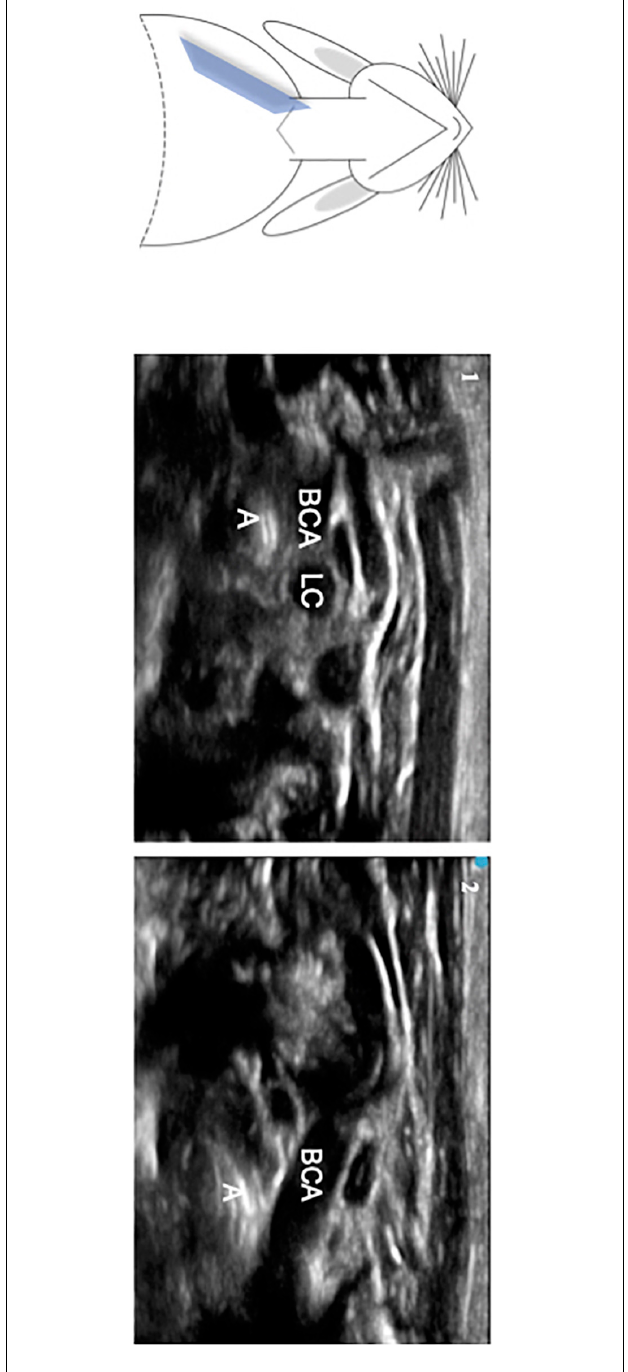
FIGURE 4 | Oblique, parasternal, and midclavicular plane of the thoracic trachea. A – trachea, LC, Left common carotid artery, BCA, brachiocephalic or innominate artery. Part 1 – more cephalic view. Part 2 – more caudal view, at the level of the brachiocephalic